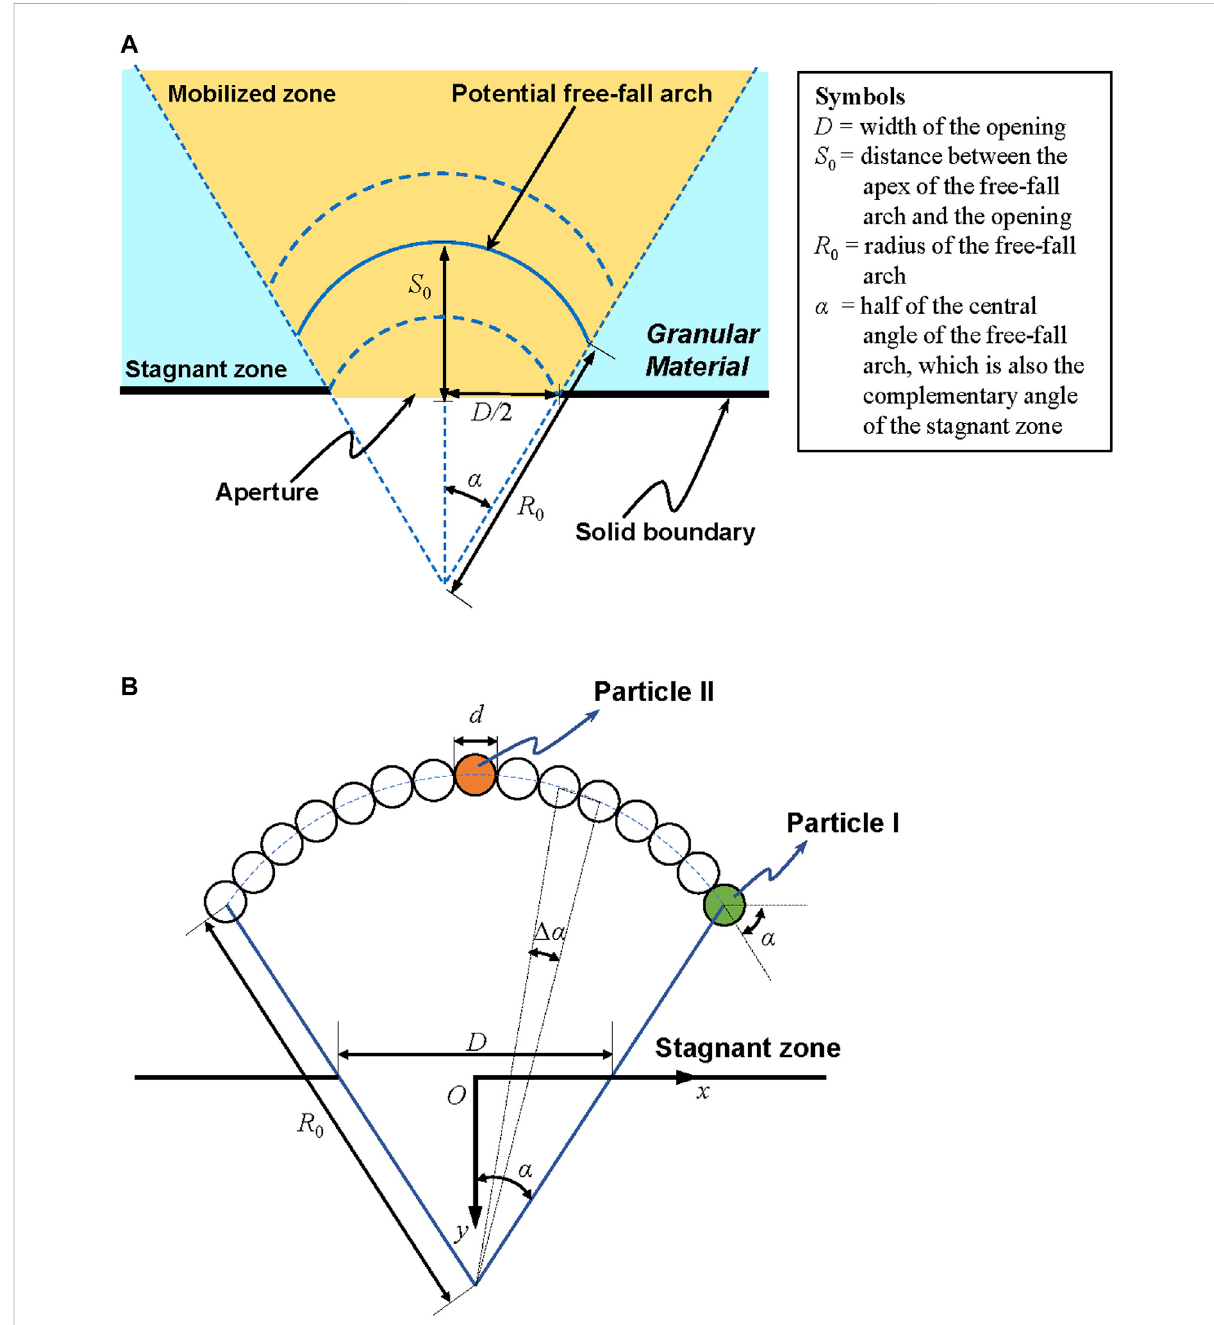
FIGURE 1 Schematic of the free-arch formation via granular fl ow through an aperture: (A) sketch of the potential free-fall arch; (B) schematic of the analytical model for the free-fall